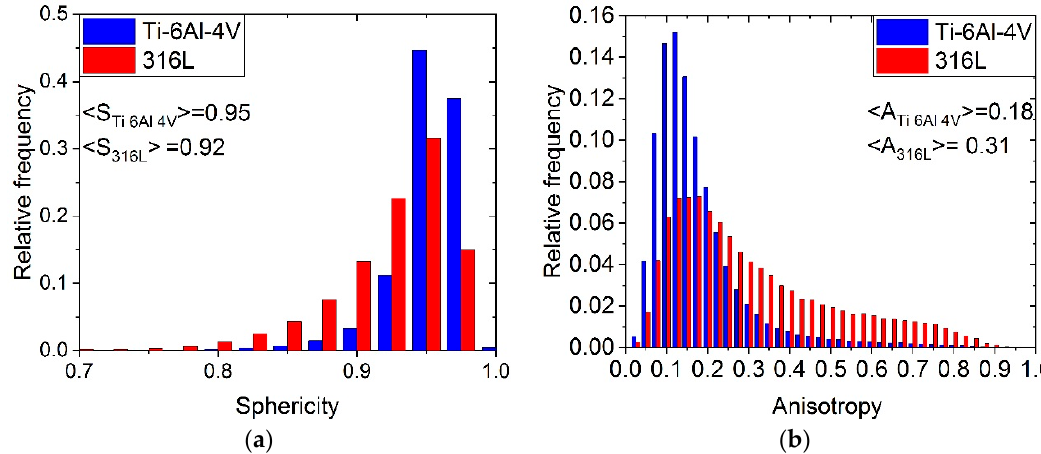
Figure 6. ( a ) The sphericity and ( b ) the anisotropy distribution of Ti–6Al–4V powder particles ( blue ) and 316L steel powder particles ( red ). The arithmetic means are presented as an inset.